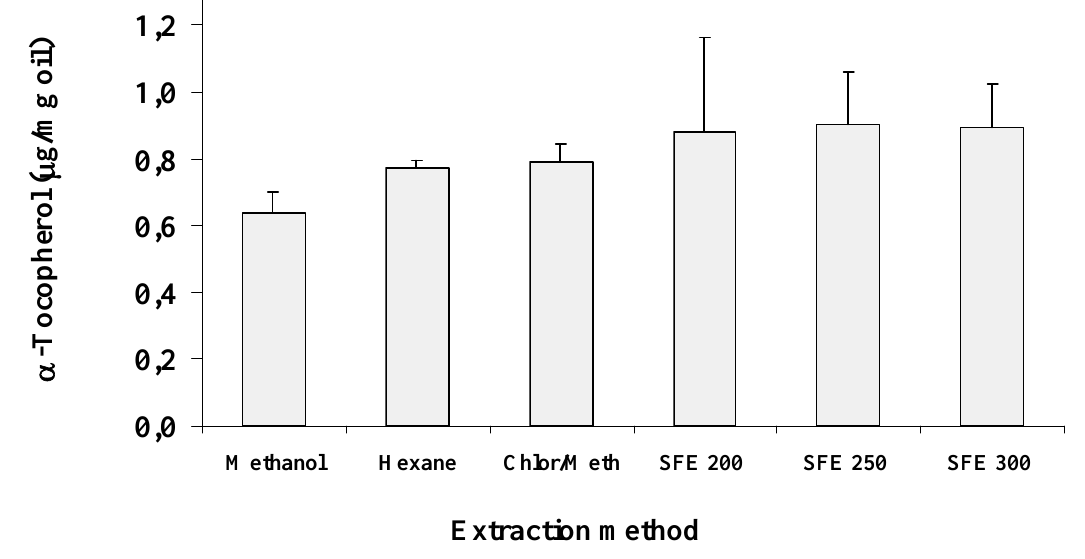
linolenic (18:3 n-3), and eicosaenoic (20:1 n-9). Table 1 also shows results for saturated (SFA), monounsaturated (MUFA), and polyunsaturated (PUFA) fatty acids. PUFA were the main group of